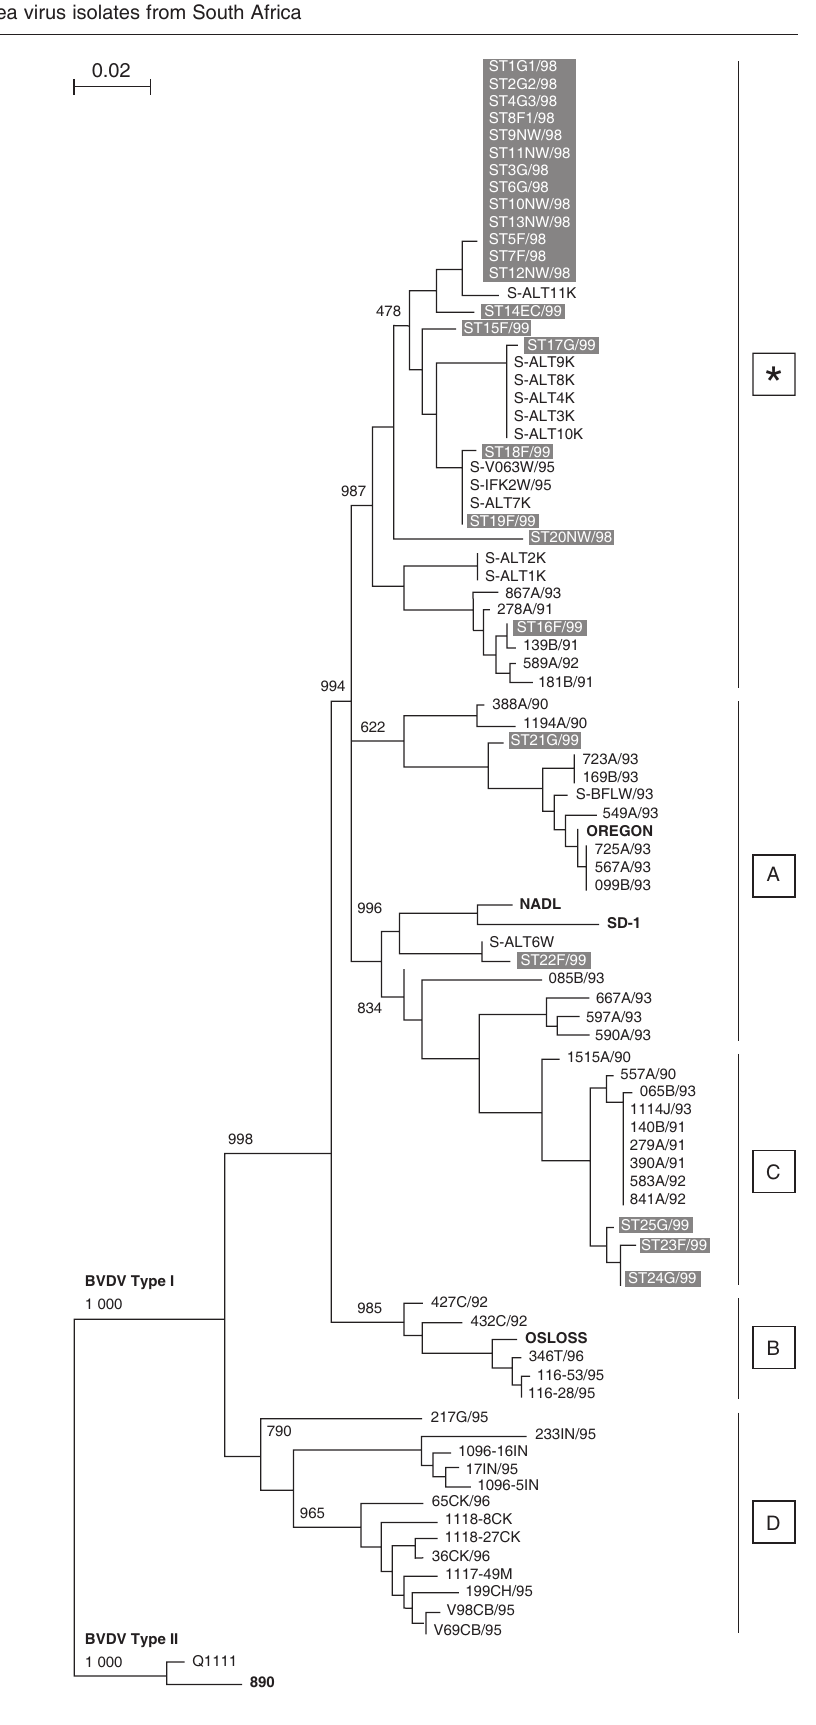
FIG. 1 Phylogenetic analysis of BVDV isolates and sequences from Genbank Reference strains of BVDV type I (NADL, OSLOSS), BVDV type II (890), BDV, HCV and isolates from a previous investigation on BVDV are in- cluded. Isolates obtained dur- ing the present investigation are indicated in bold. The phy- logeny is based on analysis of 5'NTR of the genome. The iso- lates (see Table 2) cluster into subgroup Ia, subgroup Ic and subgroup